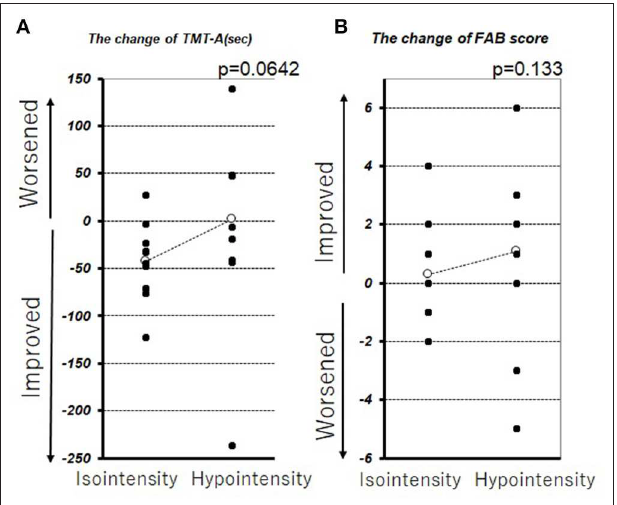
FIGURE 2 | Change in TMT-A (A) and FAB (B) before DBS therapy and 1 year after DBS therapy. The white circle represents the average.